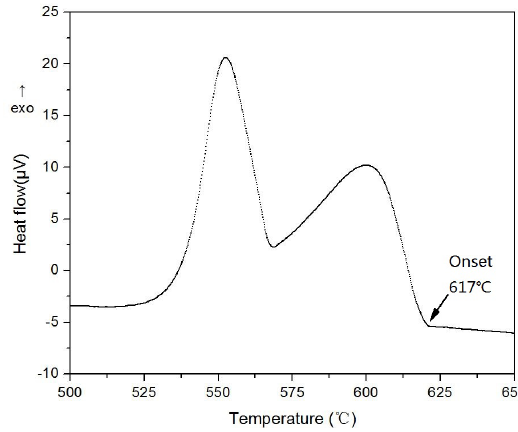
Fig. 1 DSC cooling curves of ZL101 aluminum alloy